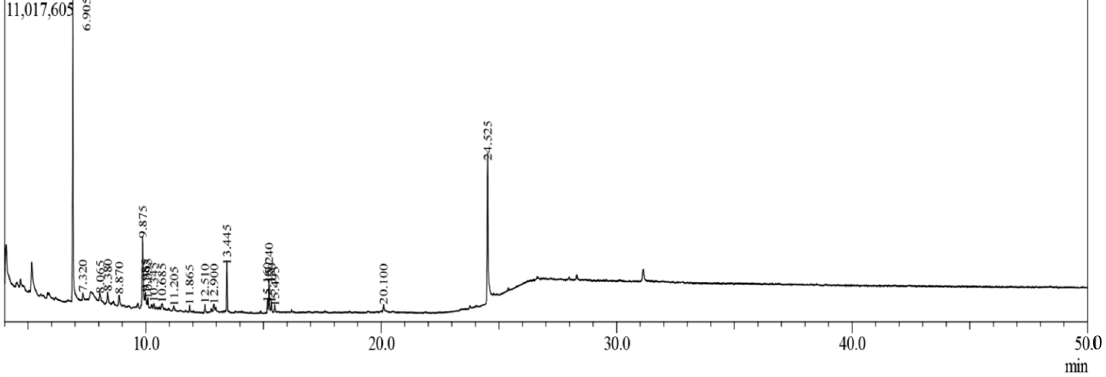
Figure 1. Total ionic chromatogram (TIC) of methanolic extract of C. velutina leaves (MECVL) by GC- MS. Table 1. Quantitative compounds identified from MECVL through the GC-MS analysis.